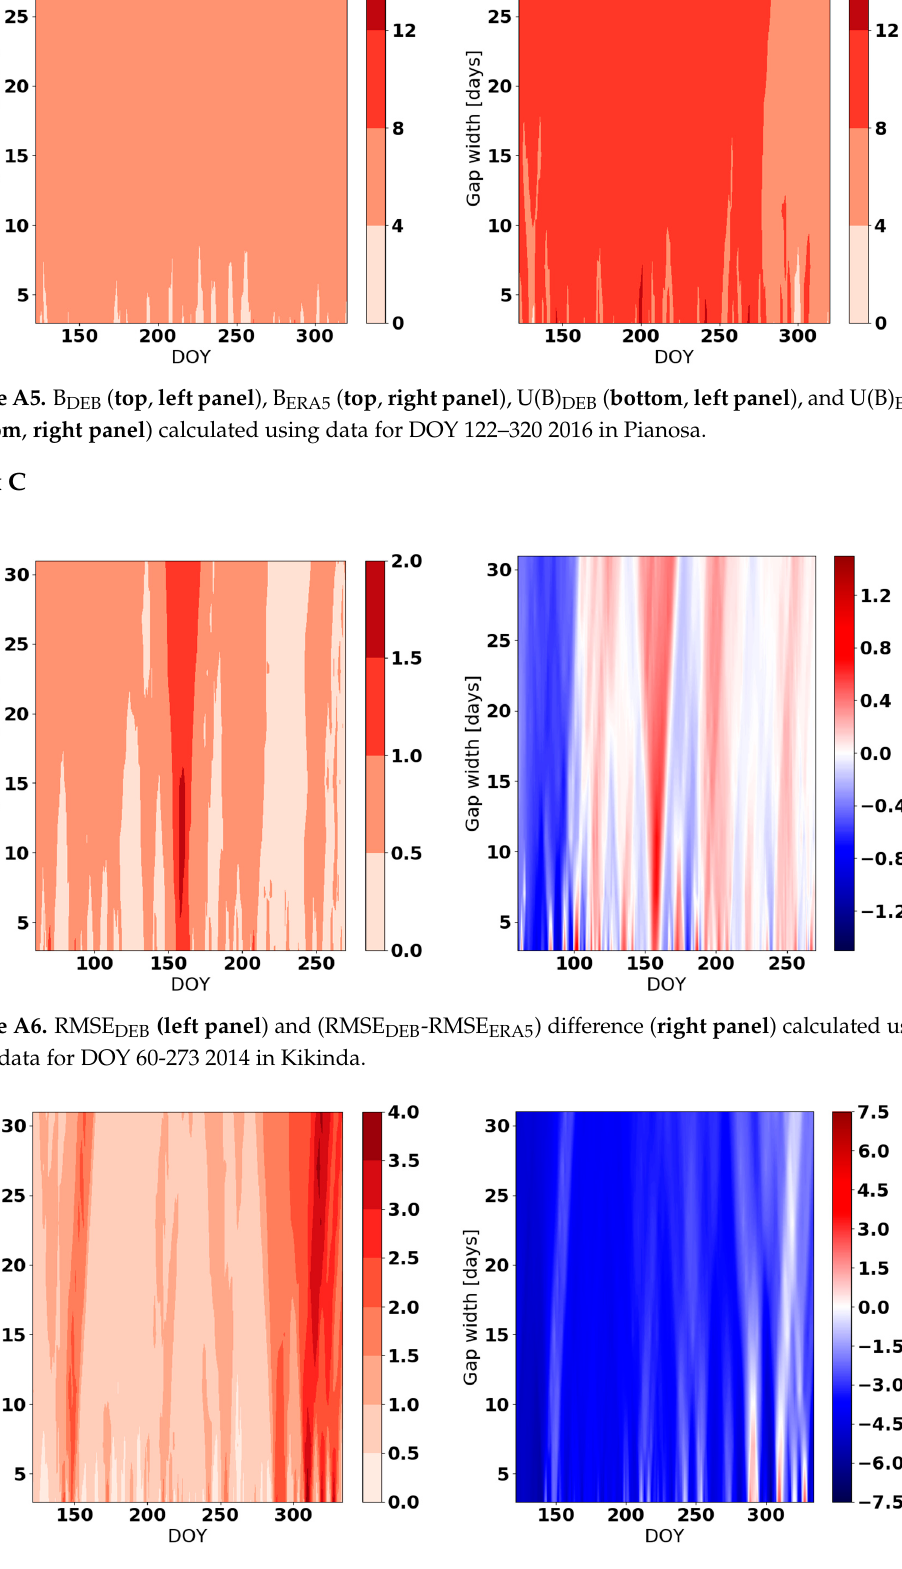
daily data for DOY 121–334 2017 in Gumpenstein.